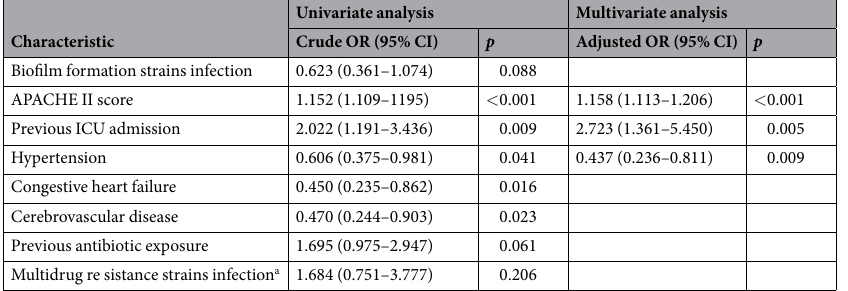
Table 2. Logistic regression analysis of predictors for 28-day mortality among patients with bacteraemic pneumonia caused by Acinetobacter baumannii . * APACHE II = Acute Physiology and Chronic Health Evaluation II, ICU = intensive care unit; CI = confidence interval, OR = odds ratio. a Definition: resistance to three or more of the following classes of antimicrobial agents: anti-pseudomonal cephalosporins, anti- pseudomonal carbapenems, ampicillin/sulbactam, fluoroquinolones, and